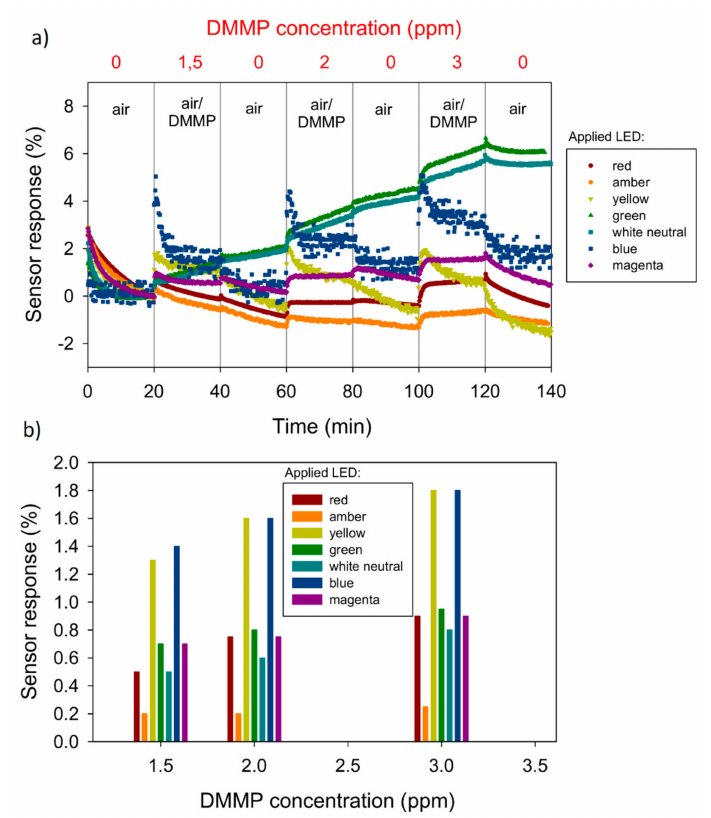
Figure 3. ( a ) The time-dependent sensor responses (SR) in the room temperature of the RR-P3HT layer activated by seven di ff erent diodes; ( b ) the dependence of sensor responses on DMMP concentration for all